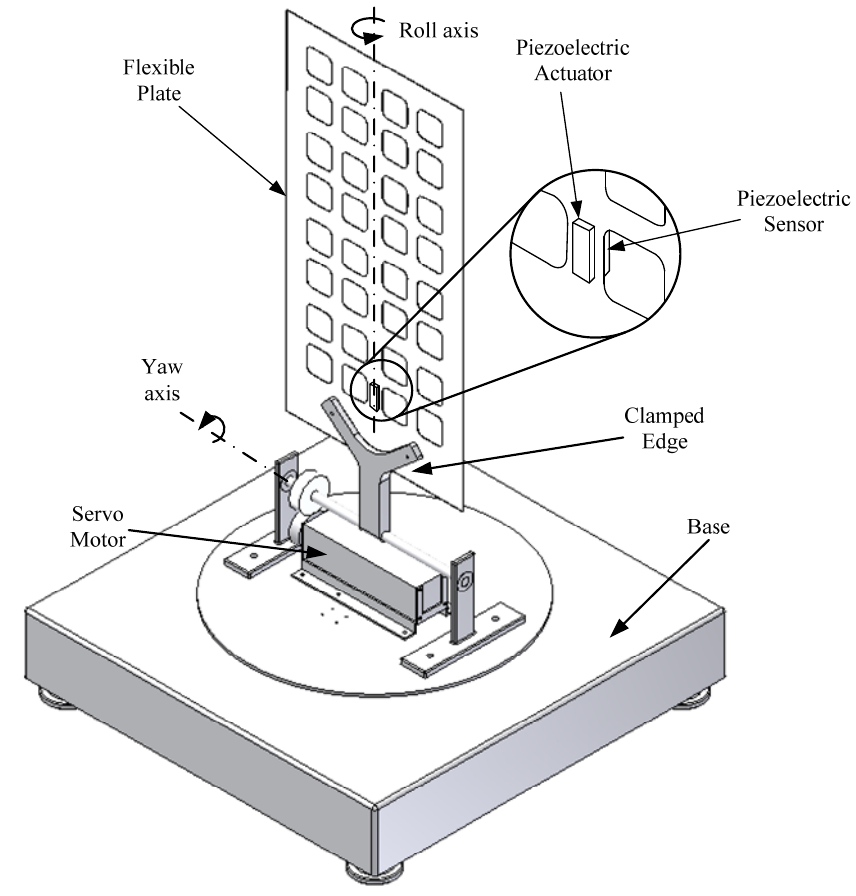
Figure 1. Motor ‐ driven system for the rotation of thin flexible plate held in a vertical position. Figure 1. Motor-driven system for the rotation of thin flexible plate held in a vertical